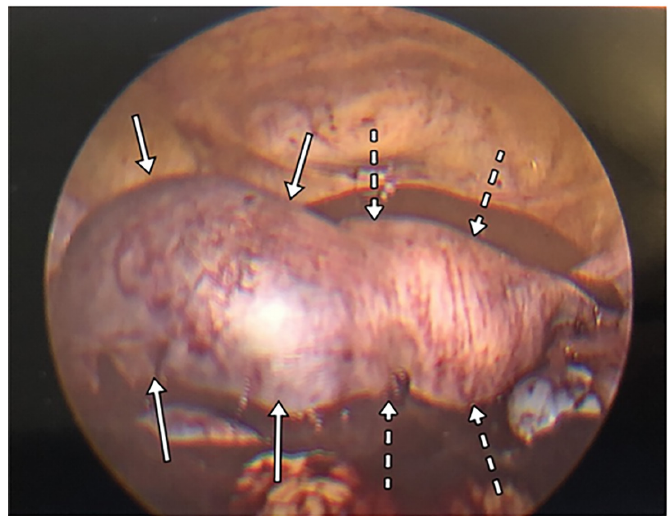
Image 3. Laparoscopic image of visualized cornual pregnancy (solid arrow) and uterus (dashed arrow) surrounded by large